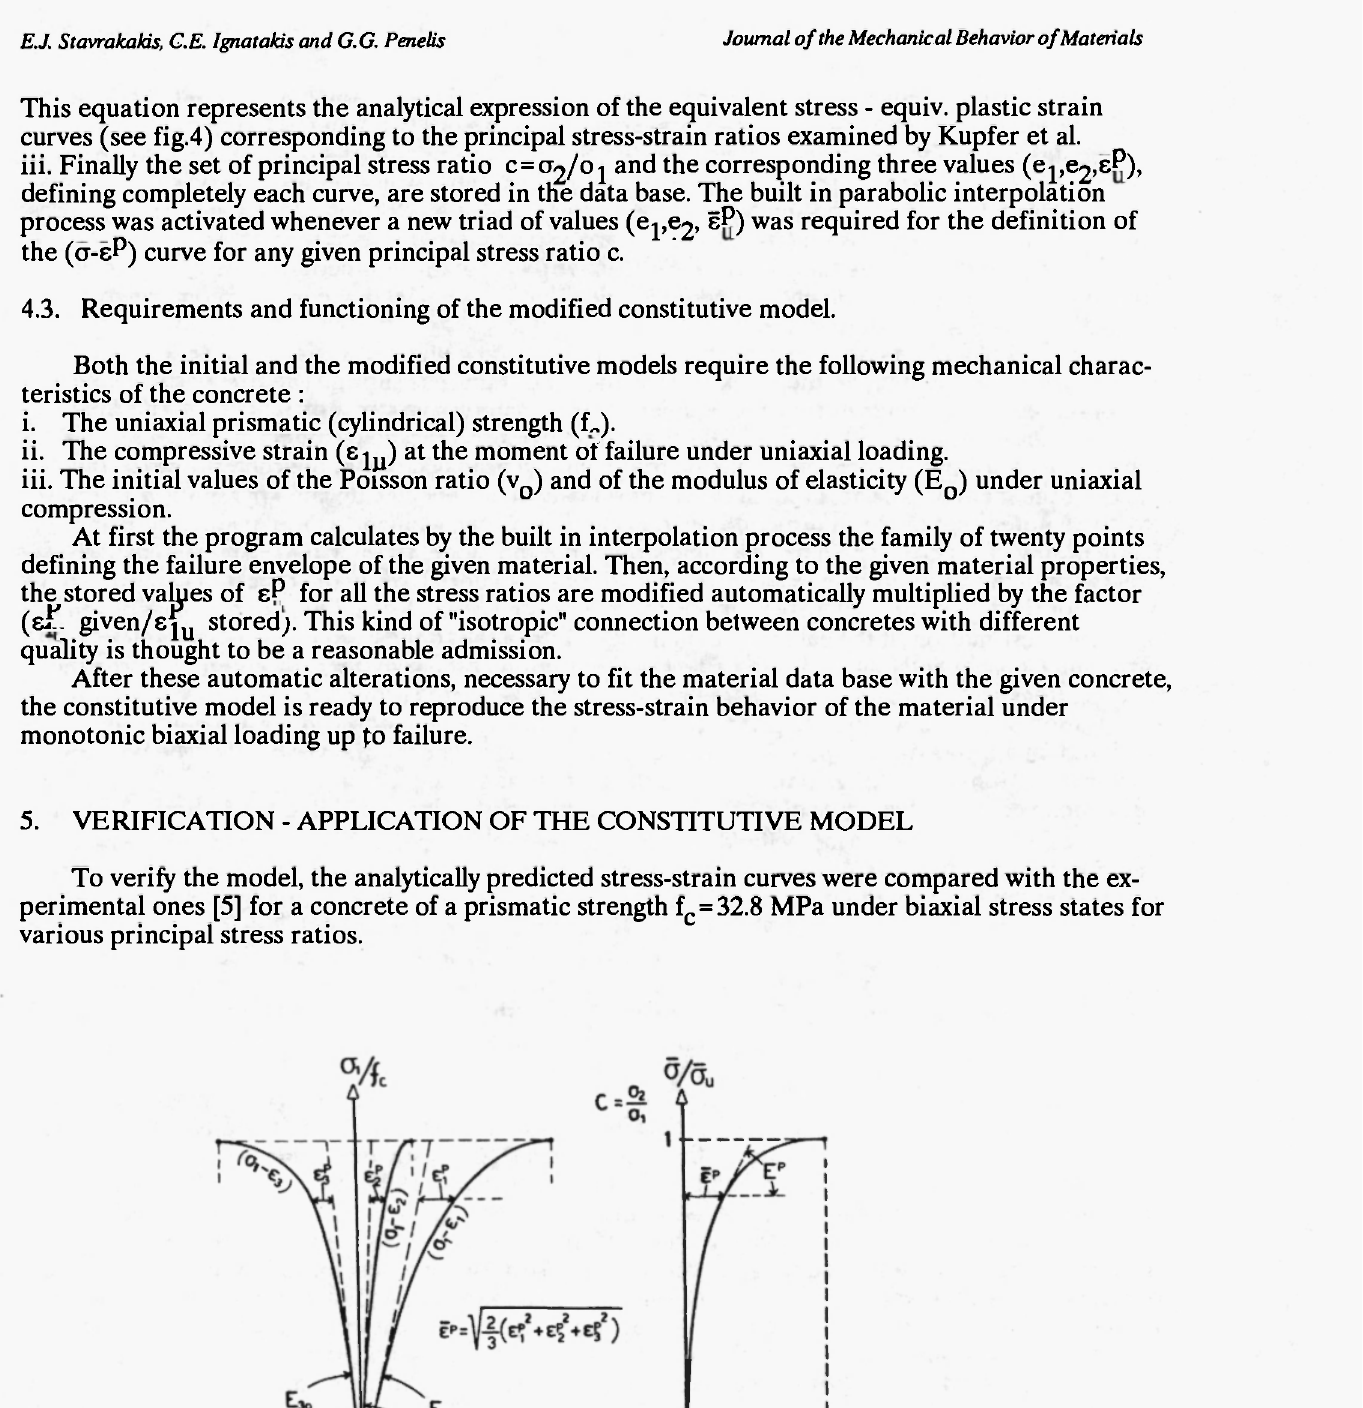
Figure 4. Typical stress-strain curves of concrete under biaxial loading and the corresponding equivalent stress- plastic strain